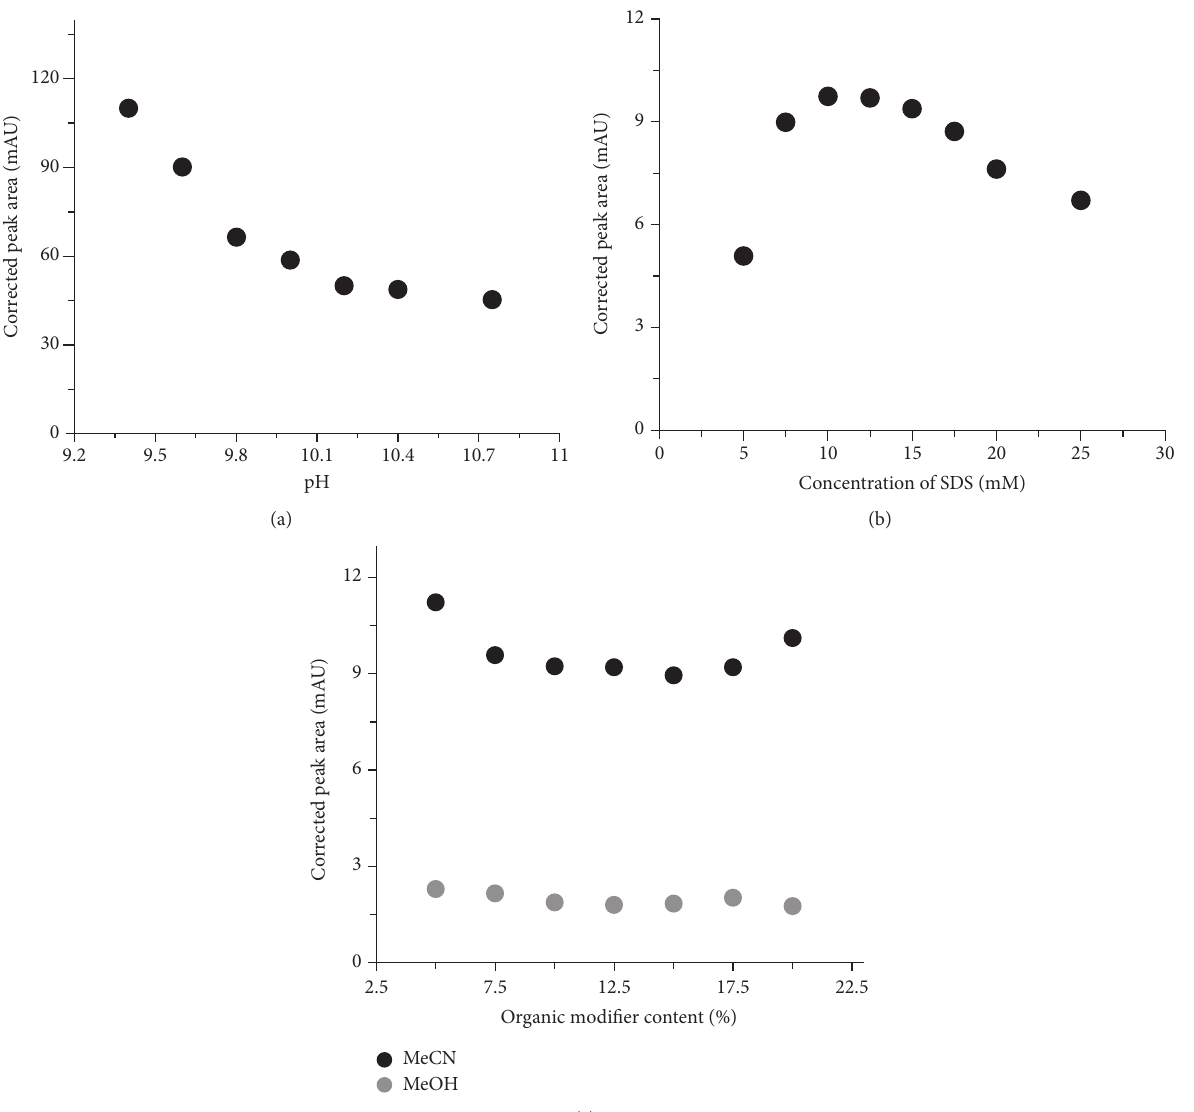
Figure 3: The influence of pH of BGE (a), SDS concentration (b), and organic modifier content (c) on peak area. Other separation conditions are described in Section